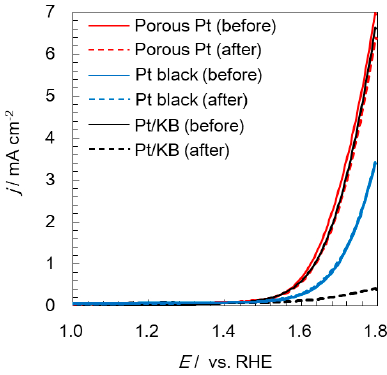
Figure 5. Linear sweep voltammograms showing oxygen evolution reaction (OER) of porous Pt, Pt black, and Pt/KB at 1600 rpm under nitrogen saturation. Solid and dotted lines show before and after the durability test, respectively.